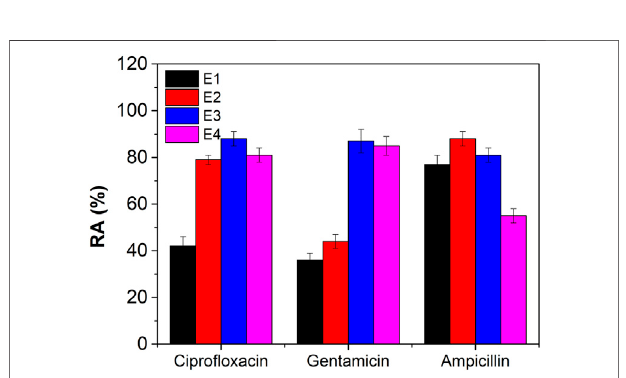
FIGURE 7 | %RA changes of E1 – E4 toward cipro fl oxacin, gentamicin, and ampicillin.